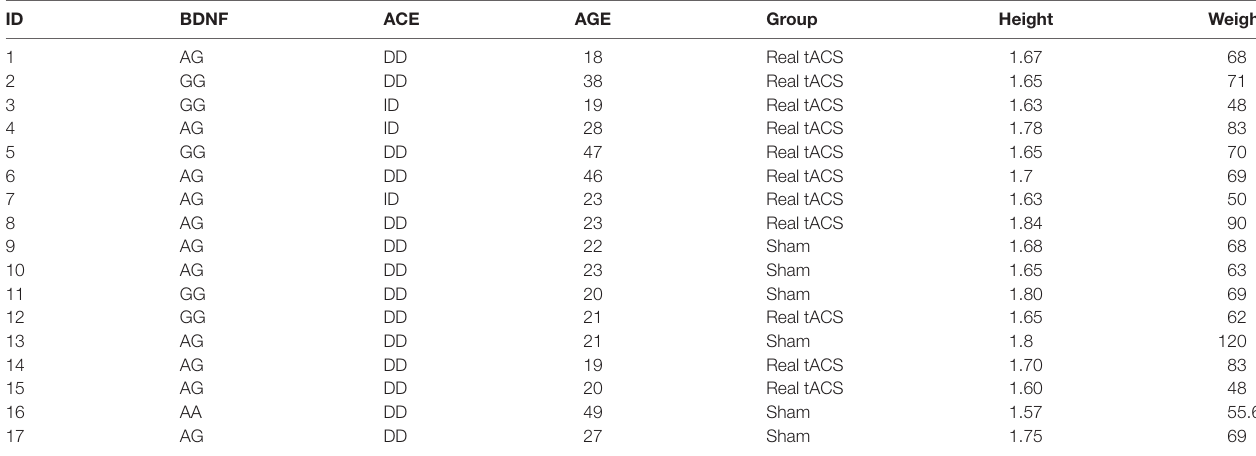
TABLE 1 | The descriptive information about the